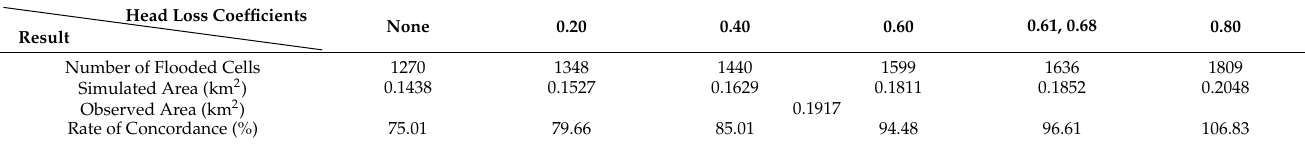
Table 7. Change of the inundation area by the application of head loss coefficients (Gunja watershed). Head Loss Result